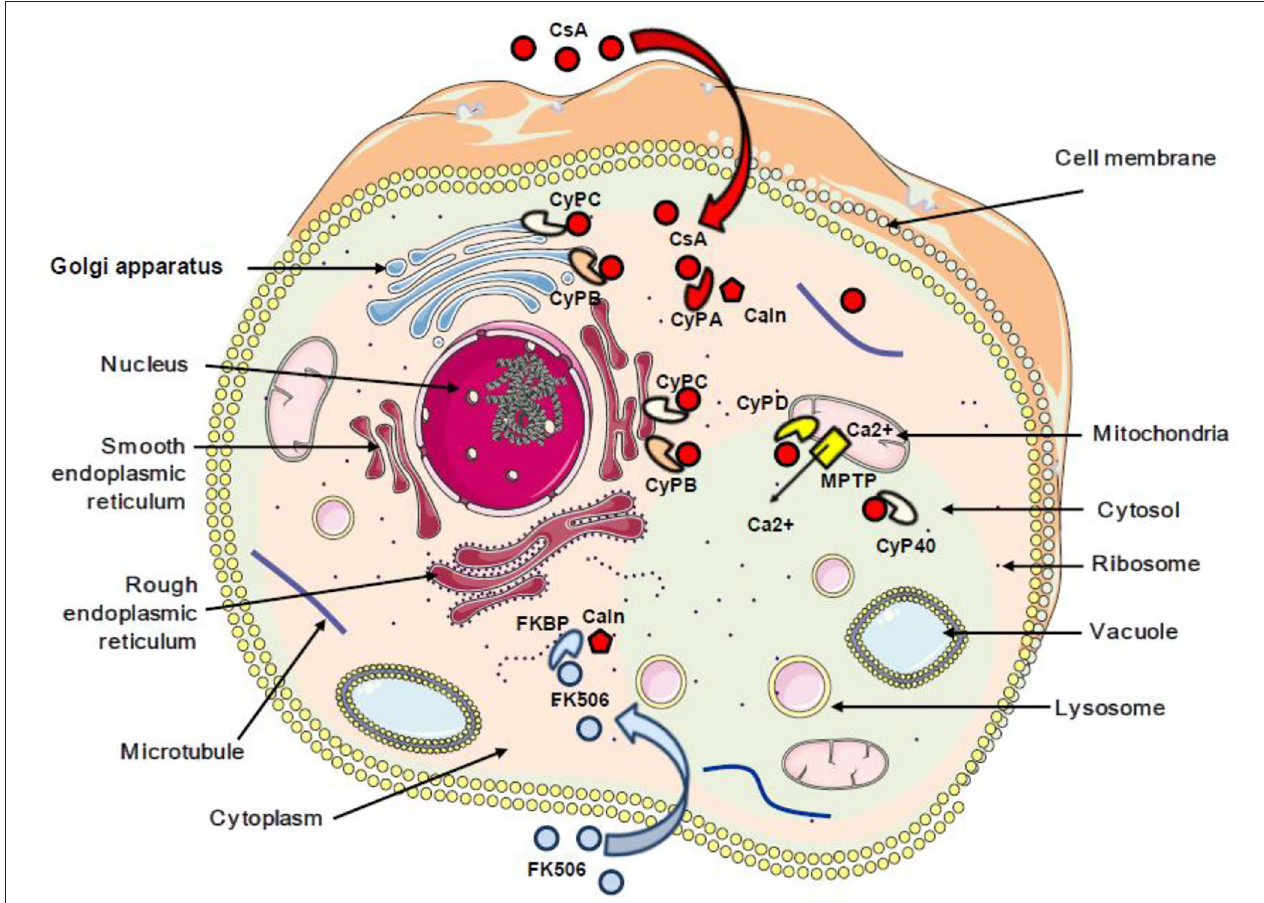
FIGURE 1 | Schematic representation of the subcellular localization of cyclophilins and FKBP proteins. The red arrow indicates the interaction between cyclosporin A and cyclophilins. The blue arrow indicates the interaction between FK506 and FKBP. CsA, cyclosporin A; CyPA, CyPB, CyPC, CyPD, and CyP40, cyclophilins A, B, C, D, and 40; FKBP, FK506-binding protein; Caln, calcineurin; MPTP, mitochondrial permeability transition pore; Ca 2 + , calcium.